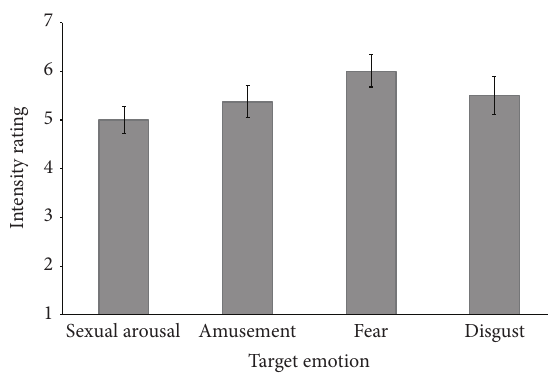
Figure 2: Emotional responses to the movie clips. Mean of self- reported emotions on a 7-point Likert scale while participants watched amusing, disgusting, fearful, and sexual arousing video excerpts. Data present mean ±